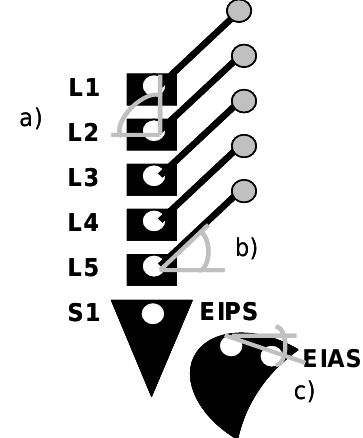
Figura 1. Cálculo das variáveis angulares (L1-L2, L2-L3, L3-L4, L4-L5, L5-S1). Esquema dos ângulos a serem calculados nos três planos a) flexão-extensão no plano sagital e inclinação lateral no plano frontal; b) rotação no plano frontal; c) inclinação pélvica no plano